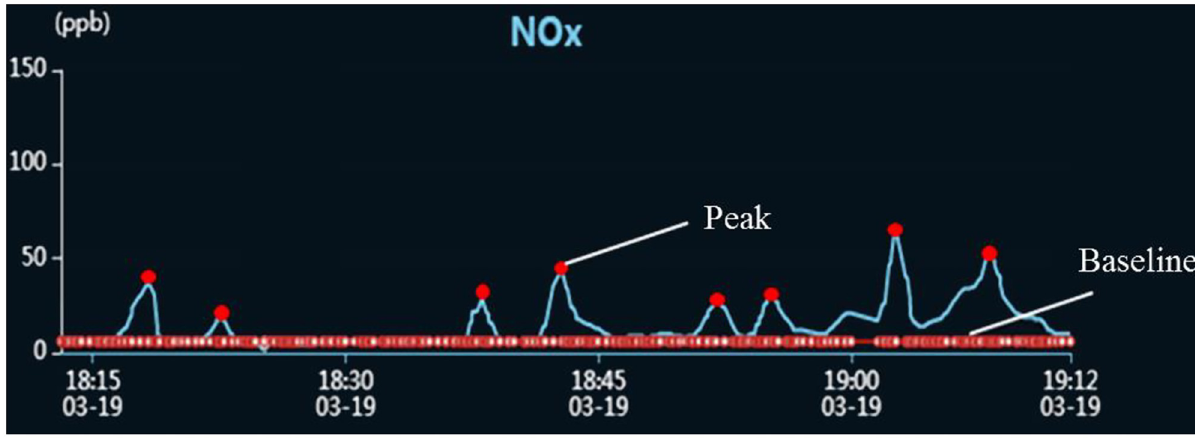
Fig 5. NO signal with smooth baseline. x